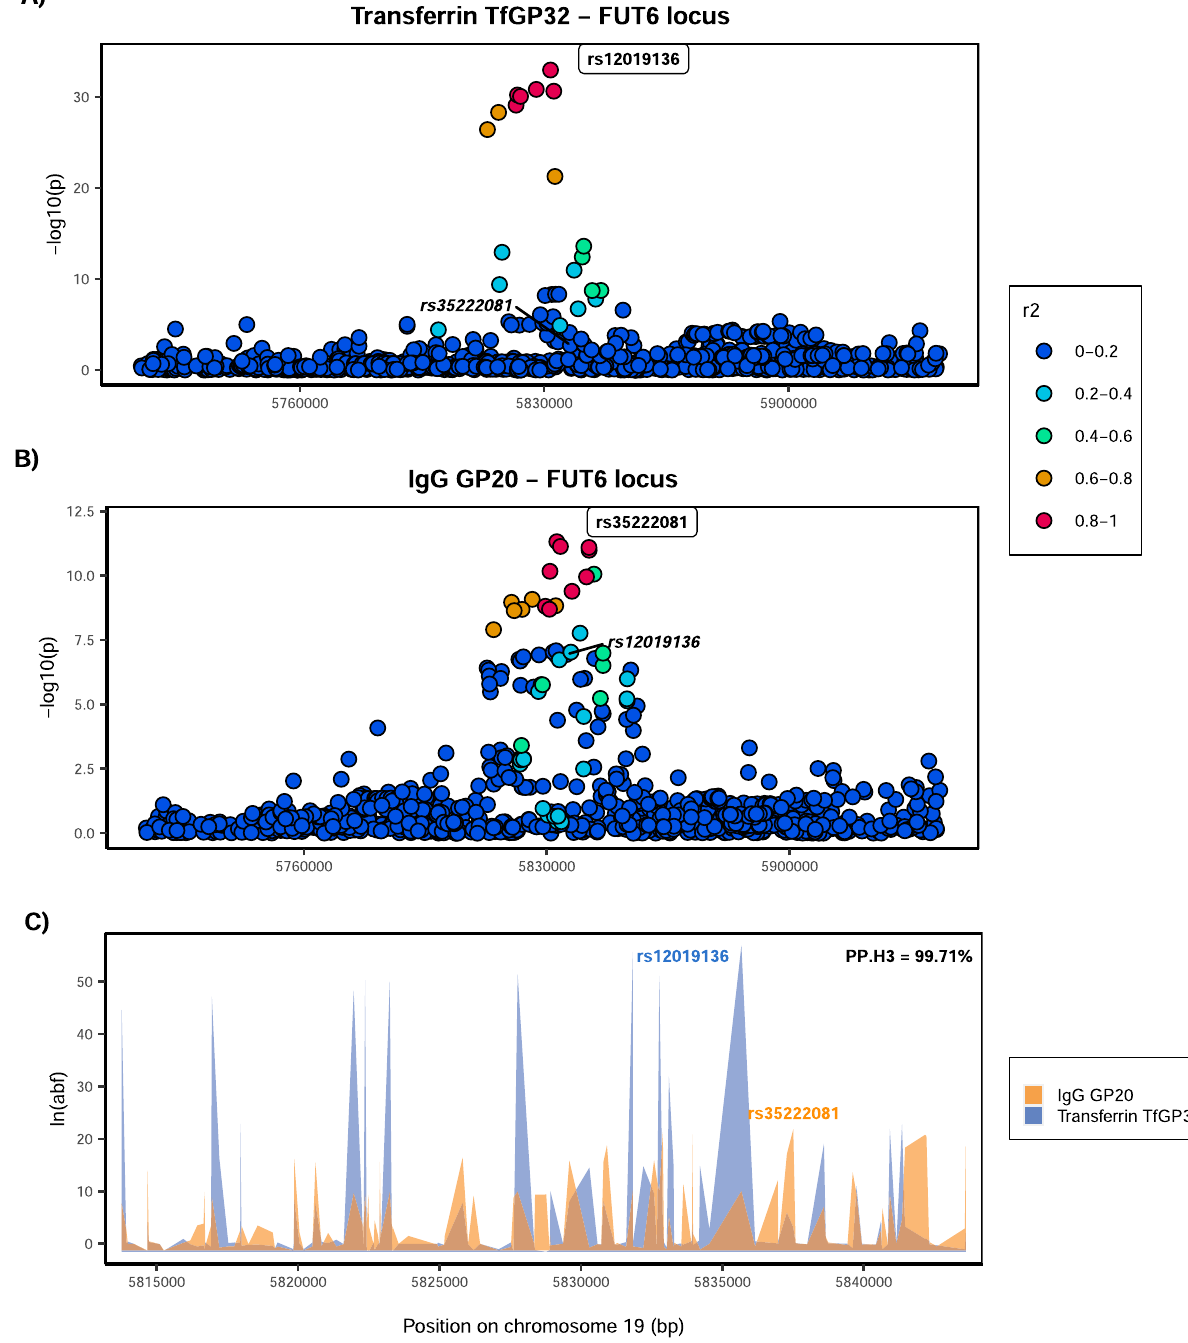
Fig. 4 Colocalisation of transferrin and IgG glycosylation traits in the FUT6 locus. Local association patterns for A transferrin TfGP32 and B IgG GP20 glycans, and C their colocalisation pattern at the FUT6 locus. TfGP32 and IgG GP20 association patterns do not colocalise, with PP.H3 (posterior probability for hypothesis 3, of different causal variants) of 99.7%. The natural logarithm of Approximate Bayes Factor (ABF) of each SNP for transferrin TfGP32 and IgG GP20 in the FUT6 region shows that TfGP32 and GP20 associations are not concordant (the patterns of ln(ABF) calculated for each SNP of both traits do not overlap), suggesting that two different underlying causal variants in this region regulate glycosylation of these two proteins. SNP most strongly associated in the region with the listed glycan trait is reported in bold and labelled. For comparison, SNP most strongly associated with the other listed glycan trait is reported in italic, in the same effects on two different substrates. If the two variants were in the from the enzymes ’ active site, suggesting that this is likely not a coding region of the gene and affected the amino acid sequence of common mechanism of regulation of fucosylation of the two the enzyme, they could affect the enzyme ’ s speci fi city for binding proteins. In addition, overall, SNPs associated with transferrin each protein. However, the sentinel variant in the FUT8 locus is glycosylation predominantly mapped to regulatory rather than not in strong linkage disequilibrium (LD) with coding variants coding regions of the genome (Supplementary Data 9). The other